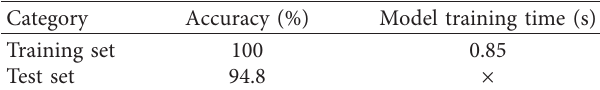
Table 3: Model training